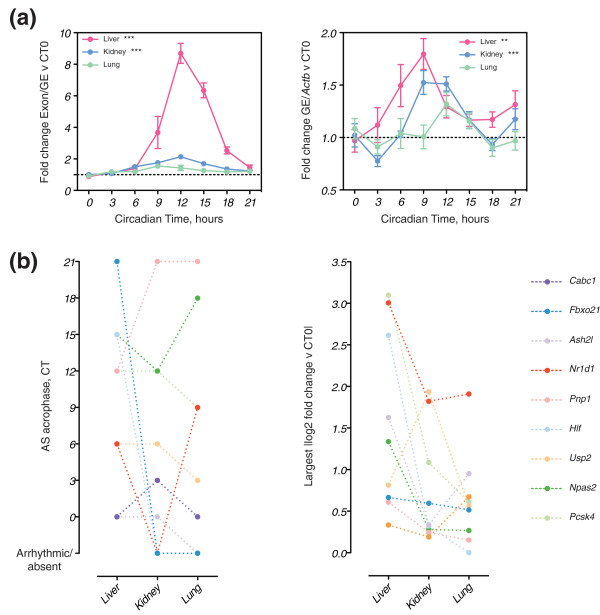
The amplitude and phase of circadian exons is tissue-dependent. (a) Plots of Pcsk4 alternative splicing (left panel) and transcript-level expression (right panel, GE, gene expression) through time in liver (pink), kidney (blue) and lung (green). In each case, n = 6 and standard error of the mean. Asterisks indicate results of a one-way ANOVA for an effect of time (**P ≤ 0.01, ***P ≤ 0.001). Individual tissue time-courses were examined where a two-way ANOVA had revealed a significant (P ≤ 0.05) main effect of tissue and/or an interaction effect between tissue and time. (b) Summary of alternative splicing data from the other validated exons (Figure S4 in Additional file 1). Left panel: acrophase of alternative splicing (AS) in three tissues. Acrophase was defined as the circadian time of the largest positive fold change versus CT0. Right panel: amplitude of alternative splicing in three tissues. Amplitude was defined as the biggest absolute value of fold change versus CT0 for exon-specific QPCR.